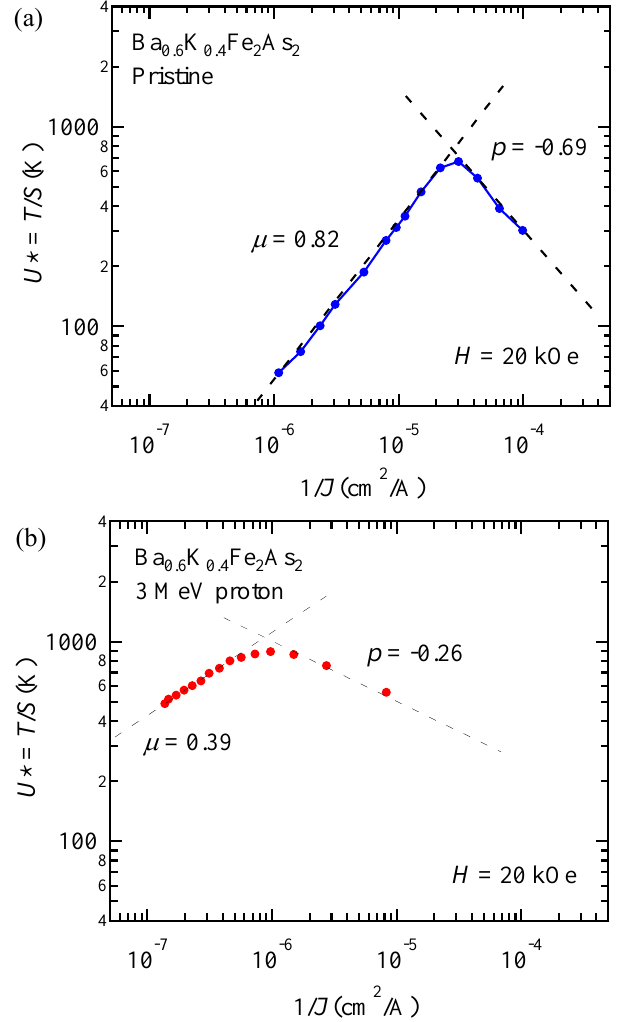
Figure 9. Inverse current density dependence of effective pinning energy U * at 20 kOe in ( a ) the pristine and ( b ) 3 MeV proton irradiated (5.6 × 10 16 ions/cm 2 ) (Ba,K)Fe 2 As 2 Table 1. Glassy exponents for elastic creep in various IBS compounds, estimated from U * vs. 1/ J plots. KCa 2 Fe 4 As 4 F 2 Pristine